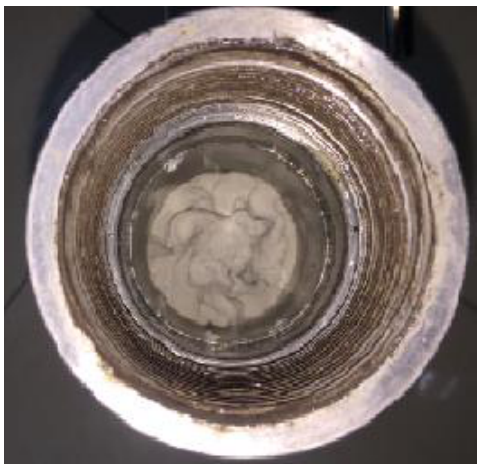
Figure 5. Sand produced in the desander.